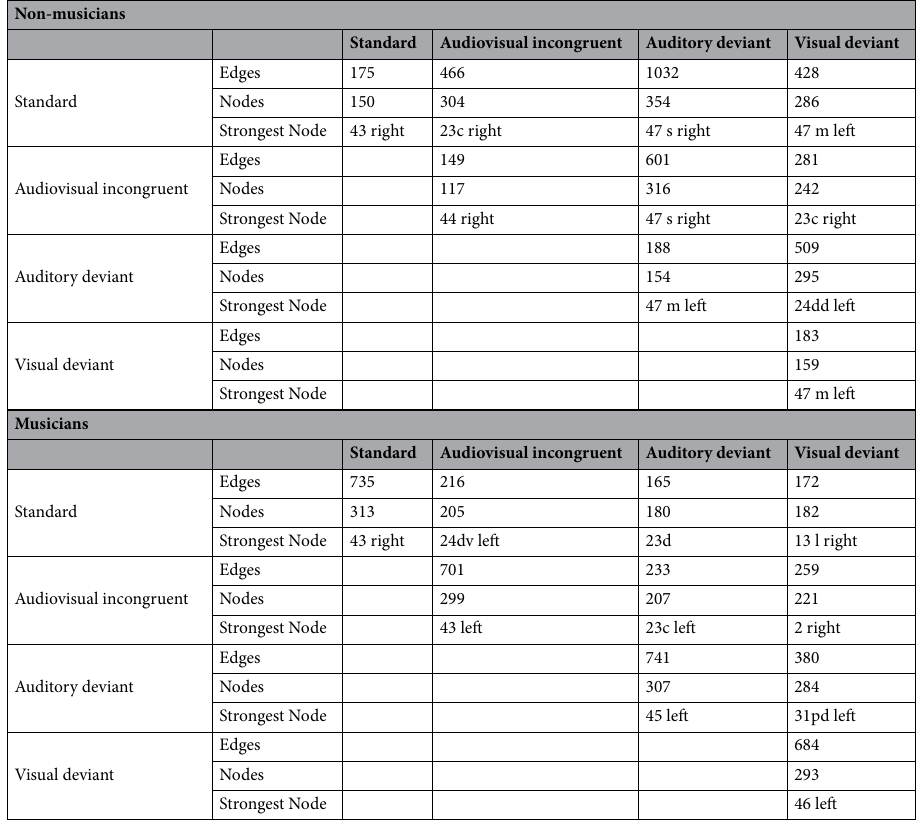
Table 1. Number (count) of significant ( p < 0.001) within and between networks multilinks in the different groups as resulted from the one-sample t-test estimating within- and between- states connectivity of each